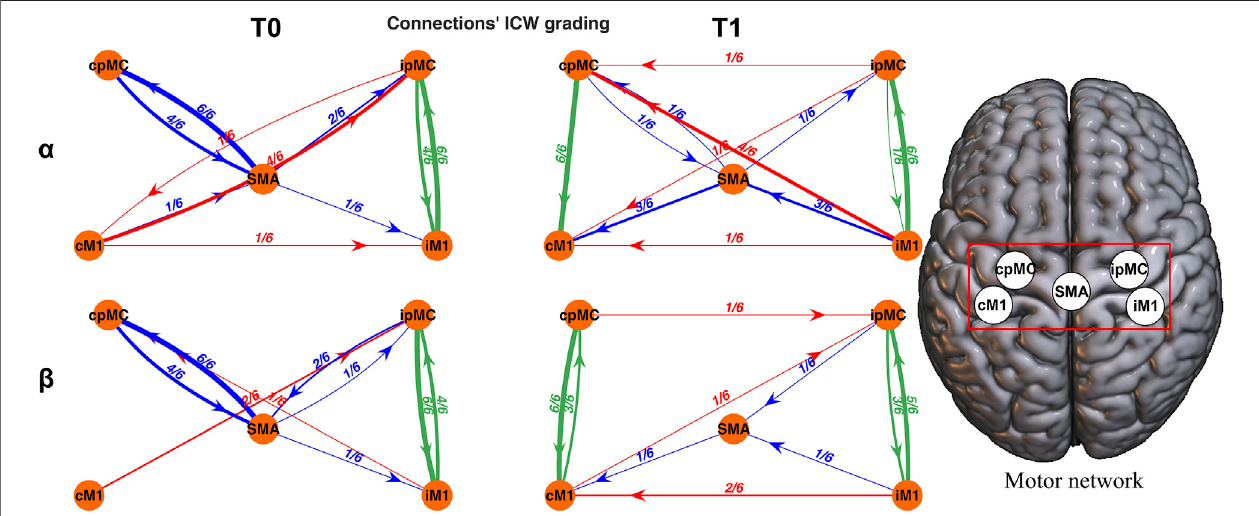
FIGURE 2 | Topographic representation of the motor network reconstructed for a representative subject. Each connection is weighted by ICW. Networks in the α ( fi rst row) and β (second row) frequency bands, at T0 (left column) and T1 (right column) are reported. Green arrows: intra-hemispheric connections; red arrows: inter- hemispheric connections; blue arrows: SMA connections.